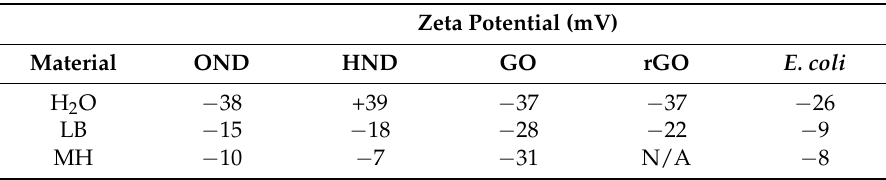
Table 3. Measured ζ -potential of the materials in water and bacterial culture media. All values have a statistical error of ± 2